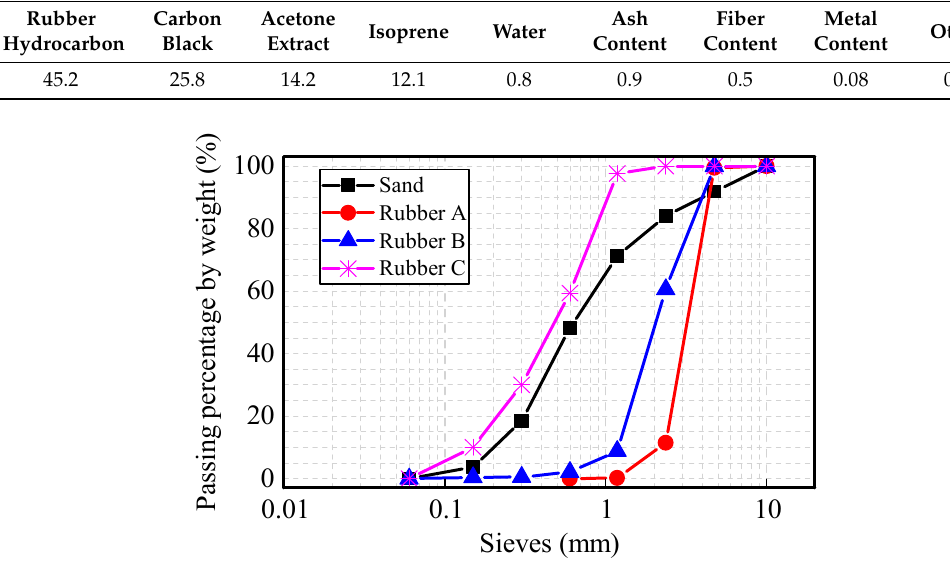
Figure 2. Particle size distribution of fine aggregates.